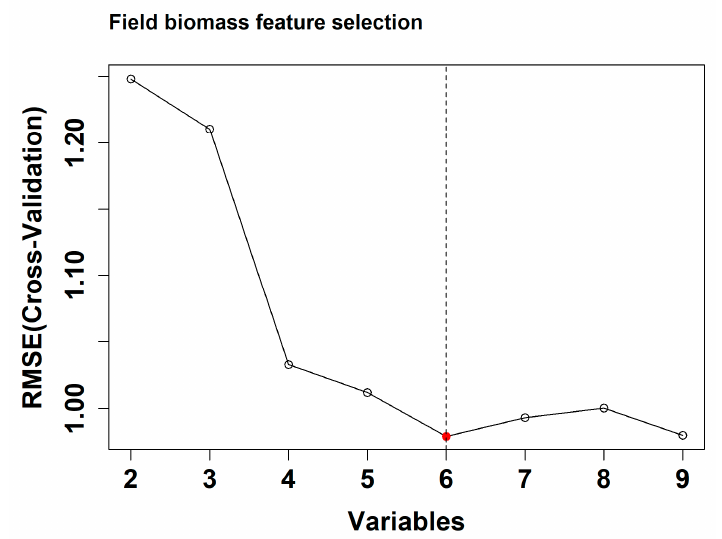
Figure 3. Field biomass model recursive feature elimination (RFE) results, indicating the optimal number of variables selected (red dot) from a 10-fold cross validation analysis. Feature selection was used to develop the Random Forest biomass models with a reduced set of optimized predictor variables.